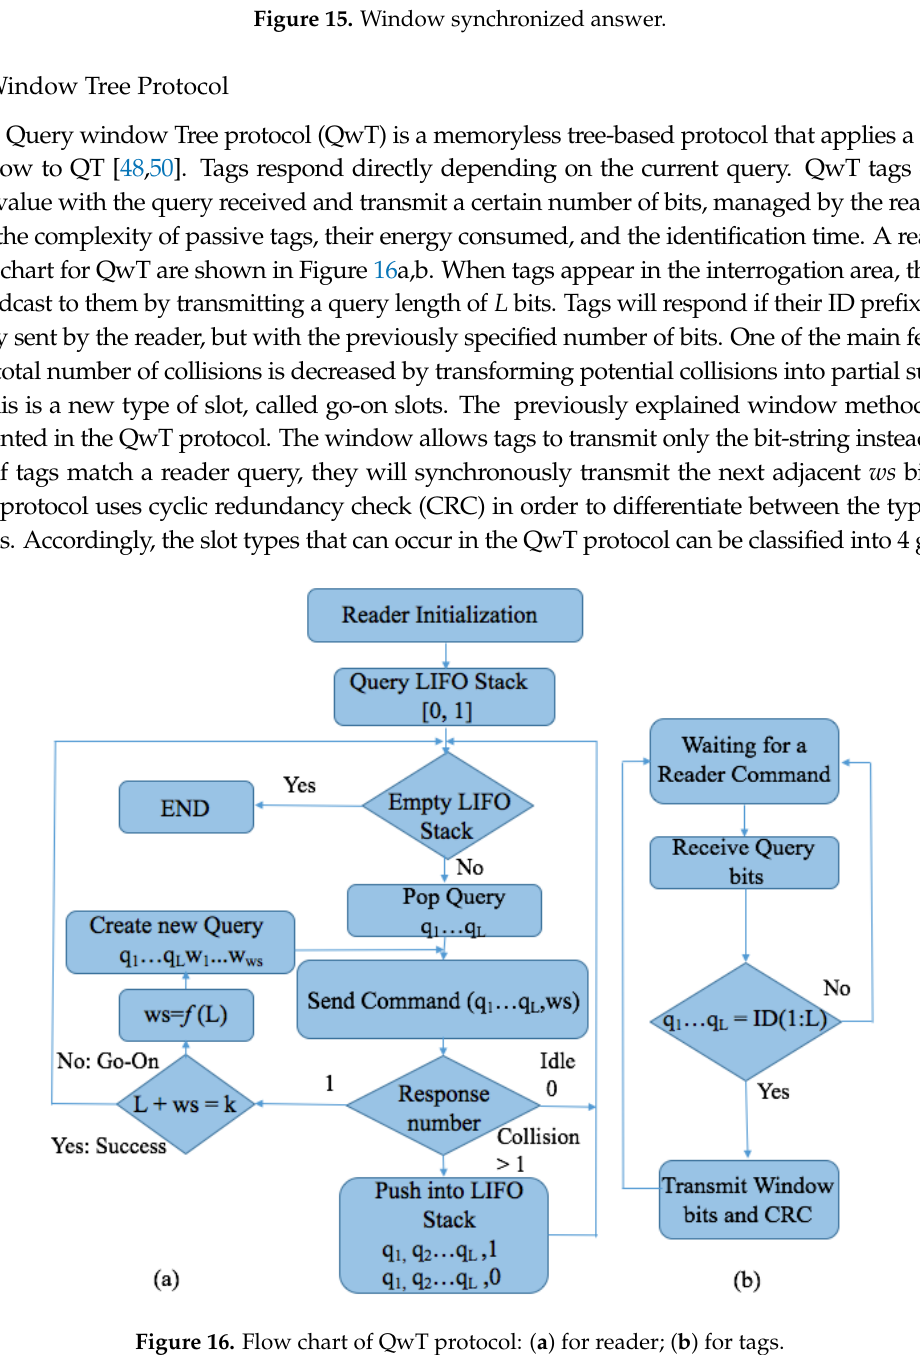
Figure 16. Flow chart of QwT protocol: ( a ) for reader; ( b ) for